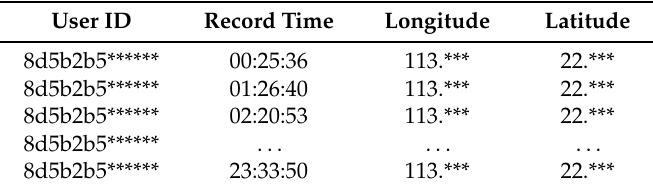
Table 1. Example of an individual’s cell phone records during a day.